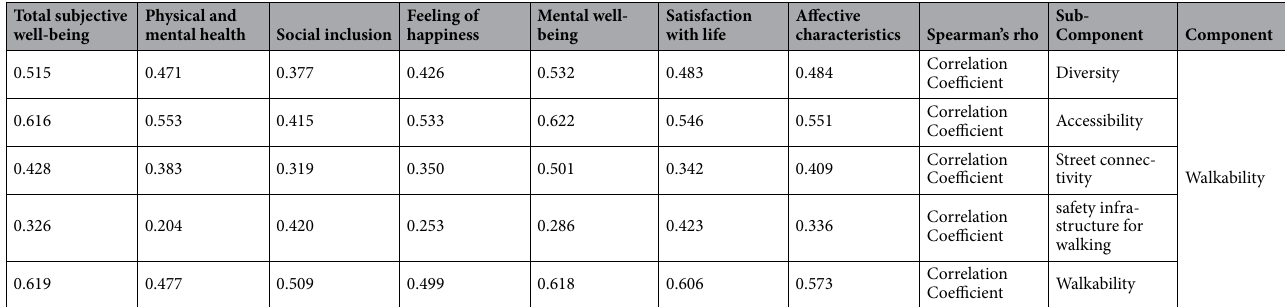
Table 5. The correlation of walkability and its sub-components with constituent components of citizens’ subjective well-being.